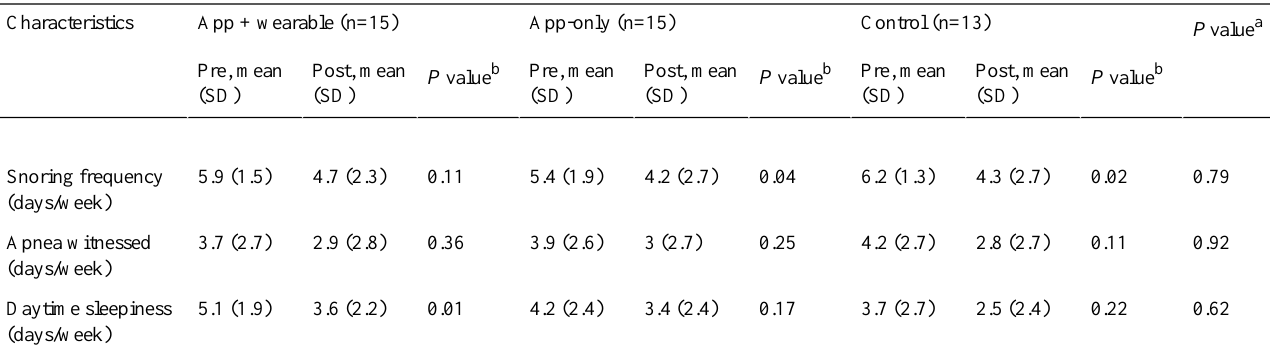
Table 3. Subjective improvement of respiratory